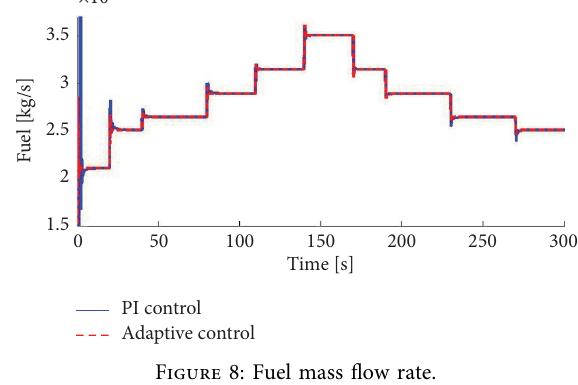
Figure 6: AFR control for the hydrogen-enriched E10 blend.